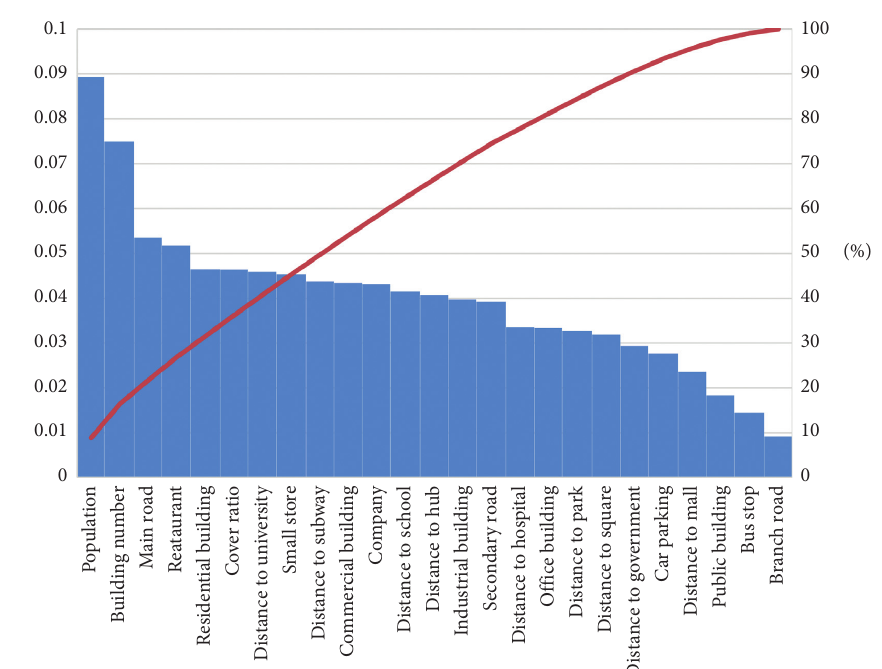
Figure 7: The importance of factor in random forest classifier model.